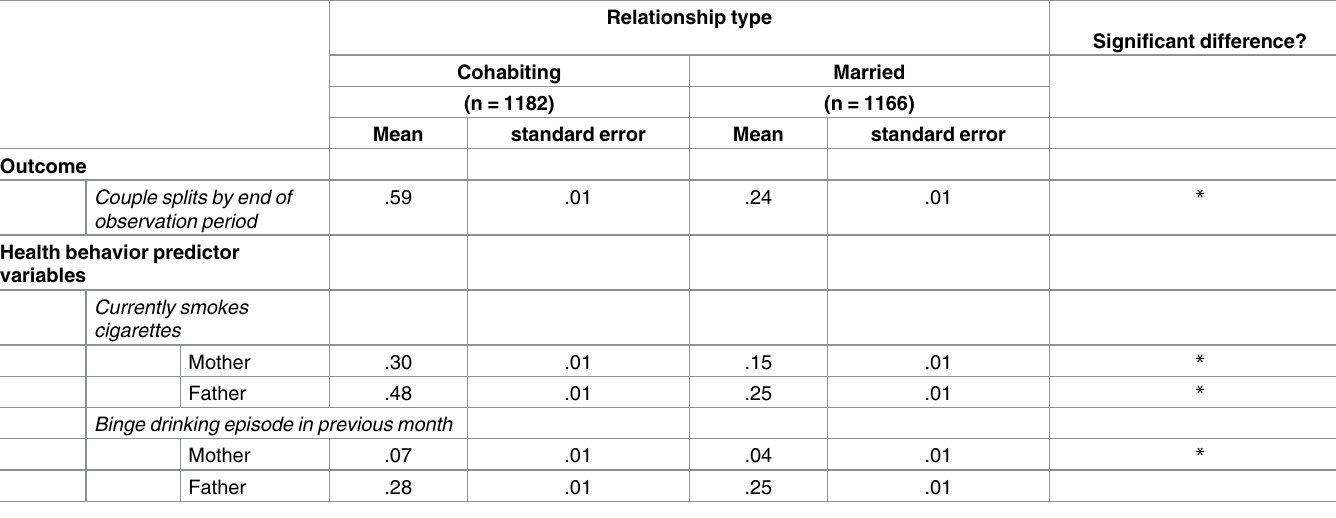
Table 1. Distribution of predictor and outcome variables by relationship